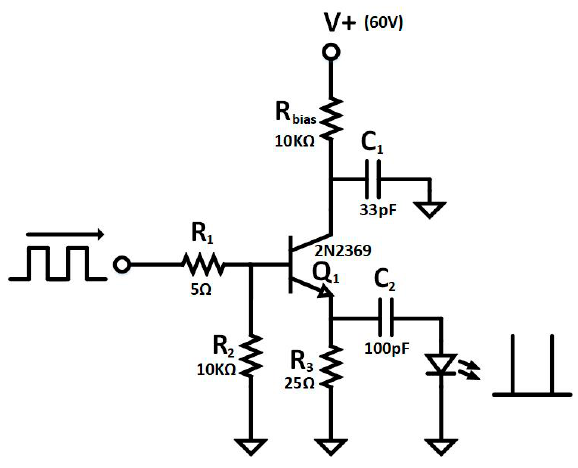
Figure 7. Simplified schematic of avalanche pulse generator.